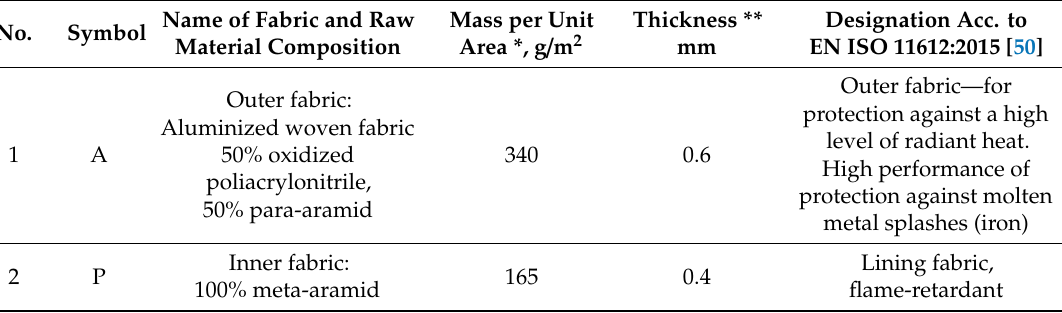
Table 1. The fabrics selected for the smart textile material with SMA elements.